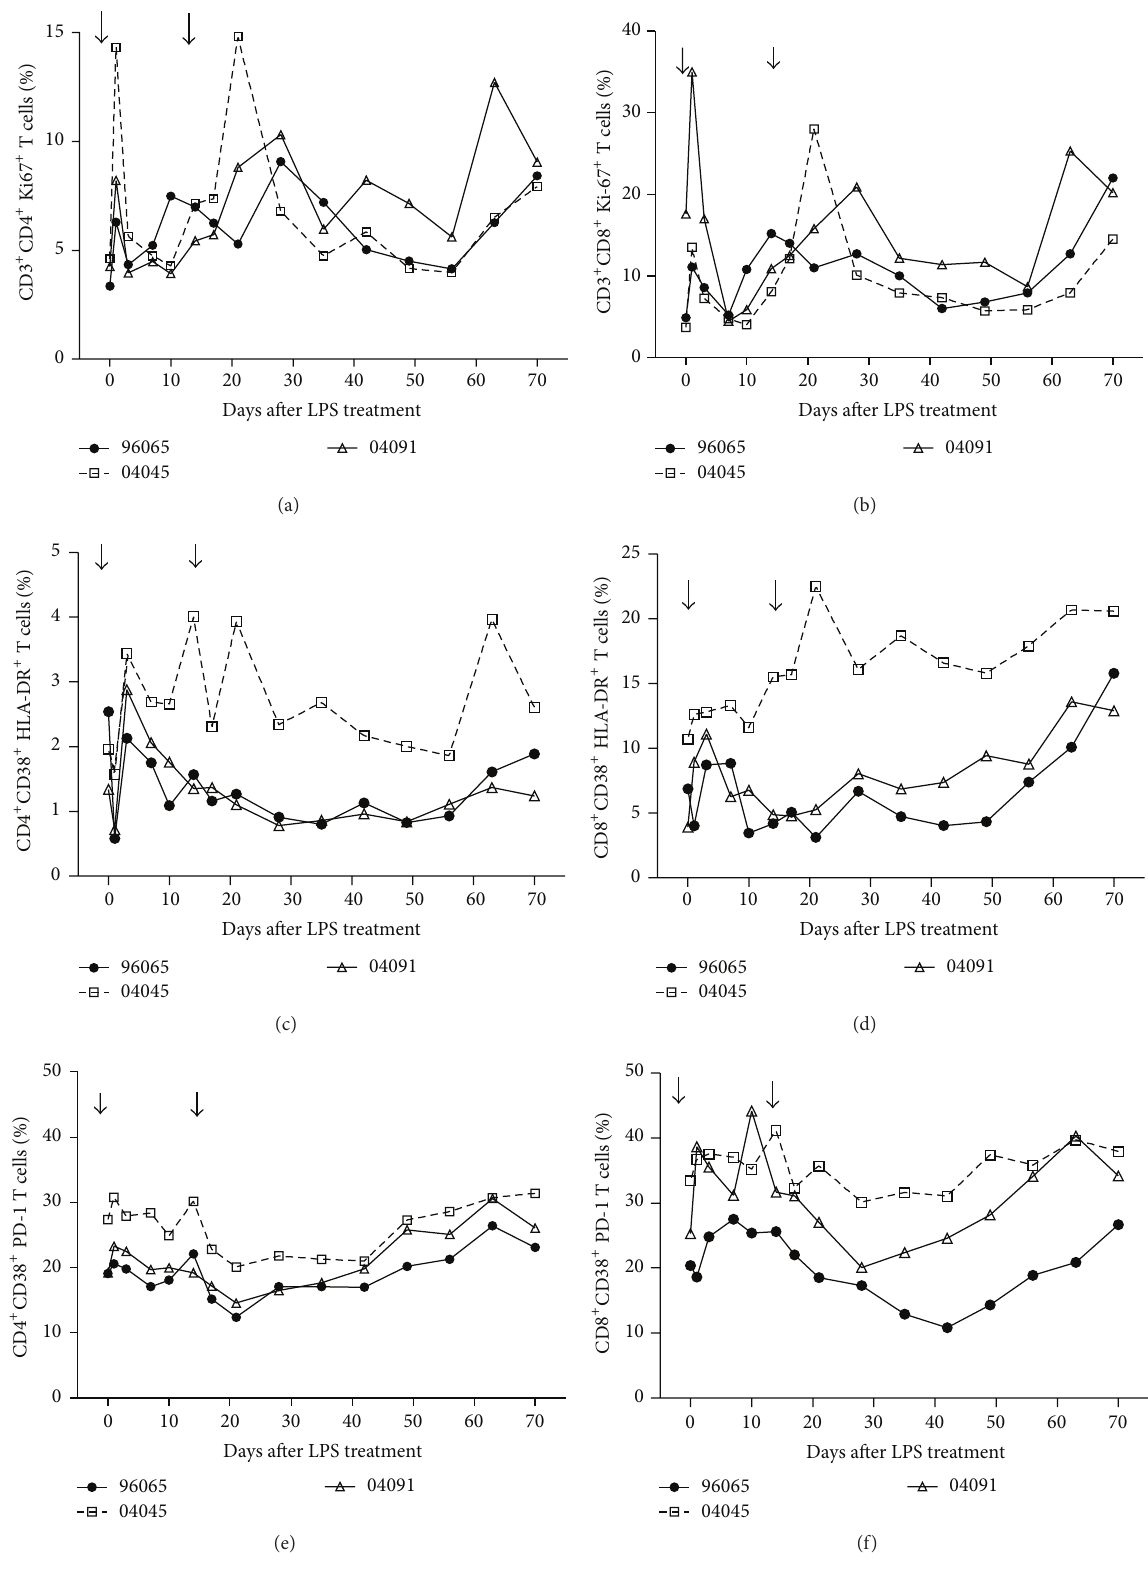
Figure 3: Impact of LPS administration on T cells in chronically SHIV -infected Ch-RMs. Increases of percentages of Ki-67 + /CD4 + T B’WHU cells (a) and Ki-67 + /CD8 + T cells (b) were observed after administration of LPS. Increases of percentages of CD38 + HLA-DR + CD4 + (c) and CD38 + HLA-DR + CD8 + T cells (d) were observed after administration of LPS. LPS did not induce remarkable changes of PD-1 on activated CD4 + (e) and CD8 + T cells